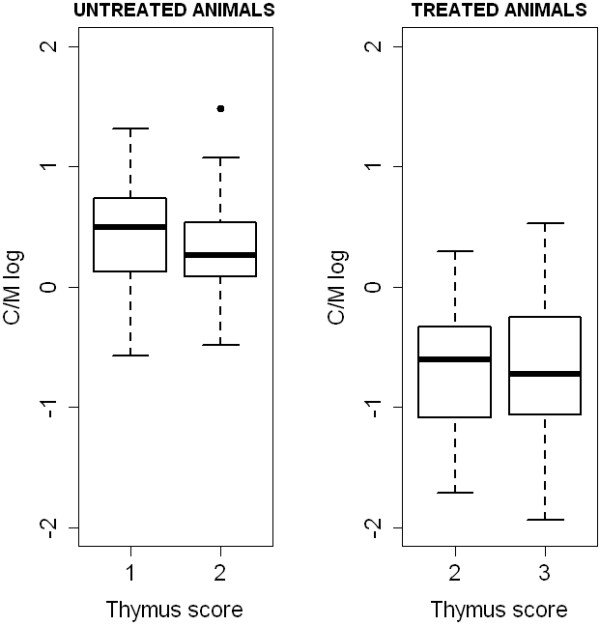
Comparison of the C/M values of samples from the same treatment group, but with different thymus scores. No significant differences were observed among control and treated animals with different thymus scores (group A: P = 0.414; group B + C: P =0.723).